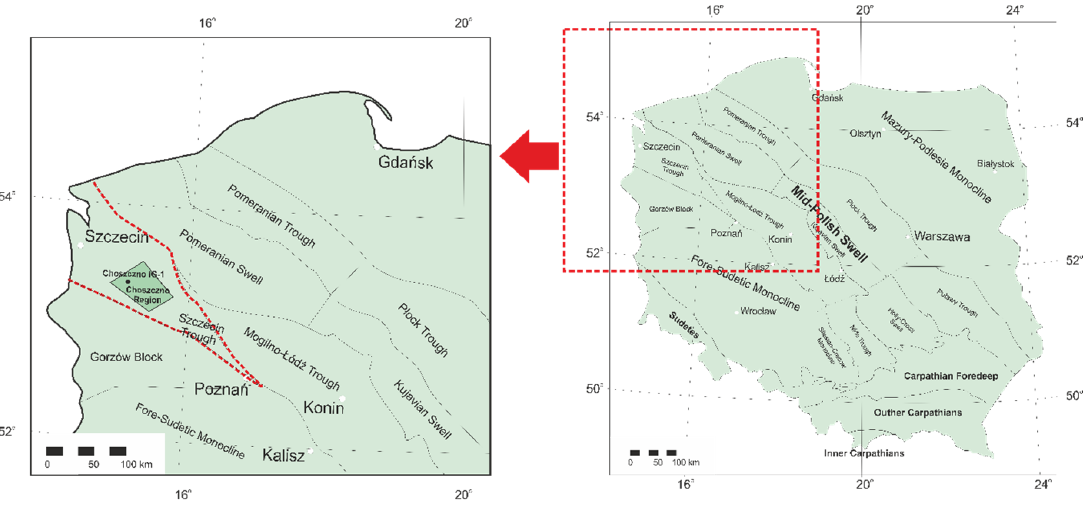
Figure 1. Location of the study area on the background map of the main tectonic units of Poland on the sub-Cenozoic surface [54].